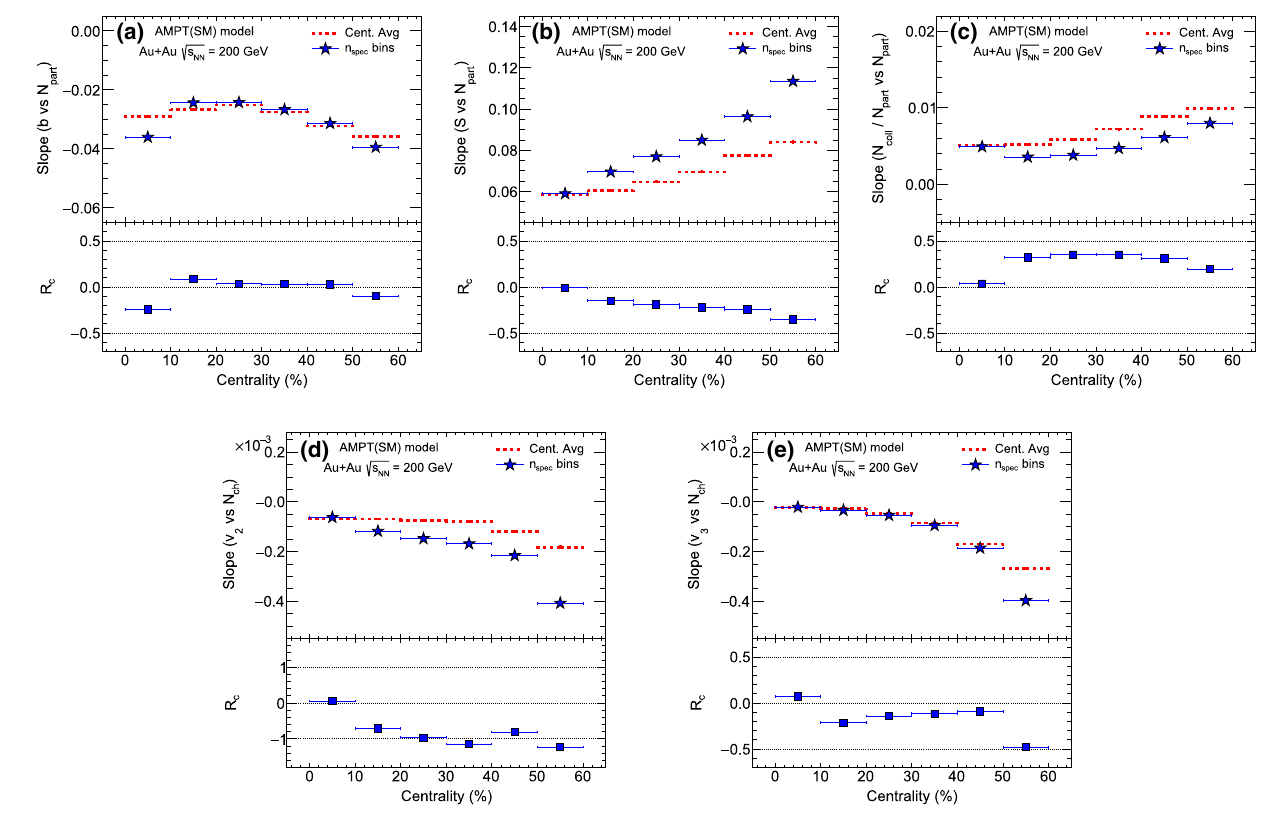
Fig. 5 Slope for centrality averaged values (red dashed line) and for L+R bins (solid stars) extracted using local linear fits. Top row: (left) slopes for b vs. N part ; (middle) slopes for S vs. N part ; (right) slopes for